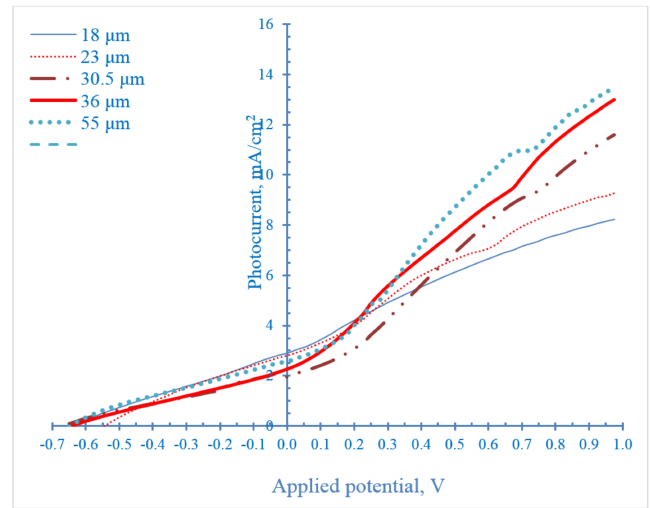
Figure 11. Effect of nanotubes length on photocurrent as a function of applied